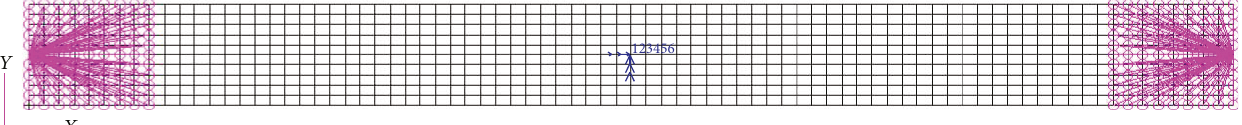
Figure 4: Finite element model of the laminates for extension-shear-coupled e ff ect veri fi cation.